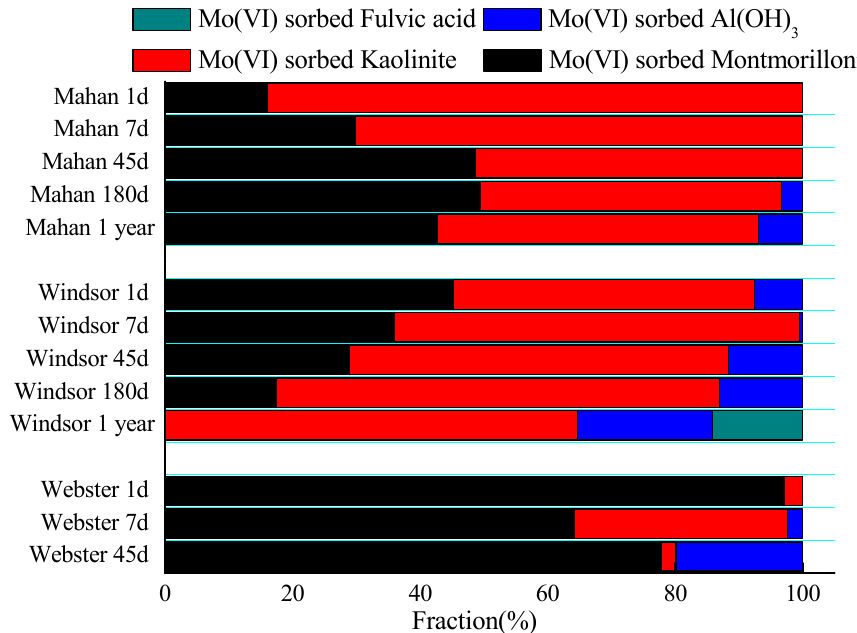
Figure 6. Mo(VI) speciation based on XANES linear combination fitting (LCF) of different reacted soils at specific times.